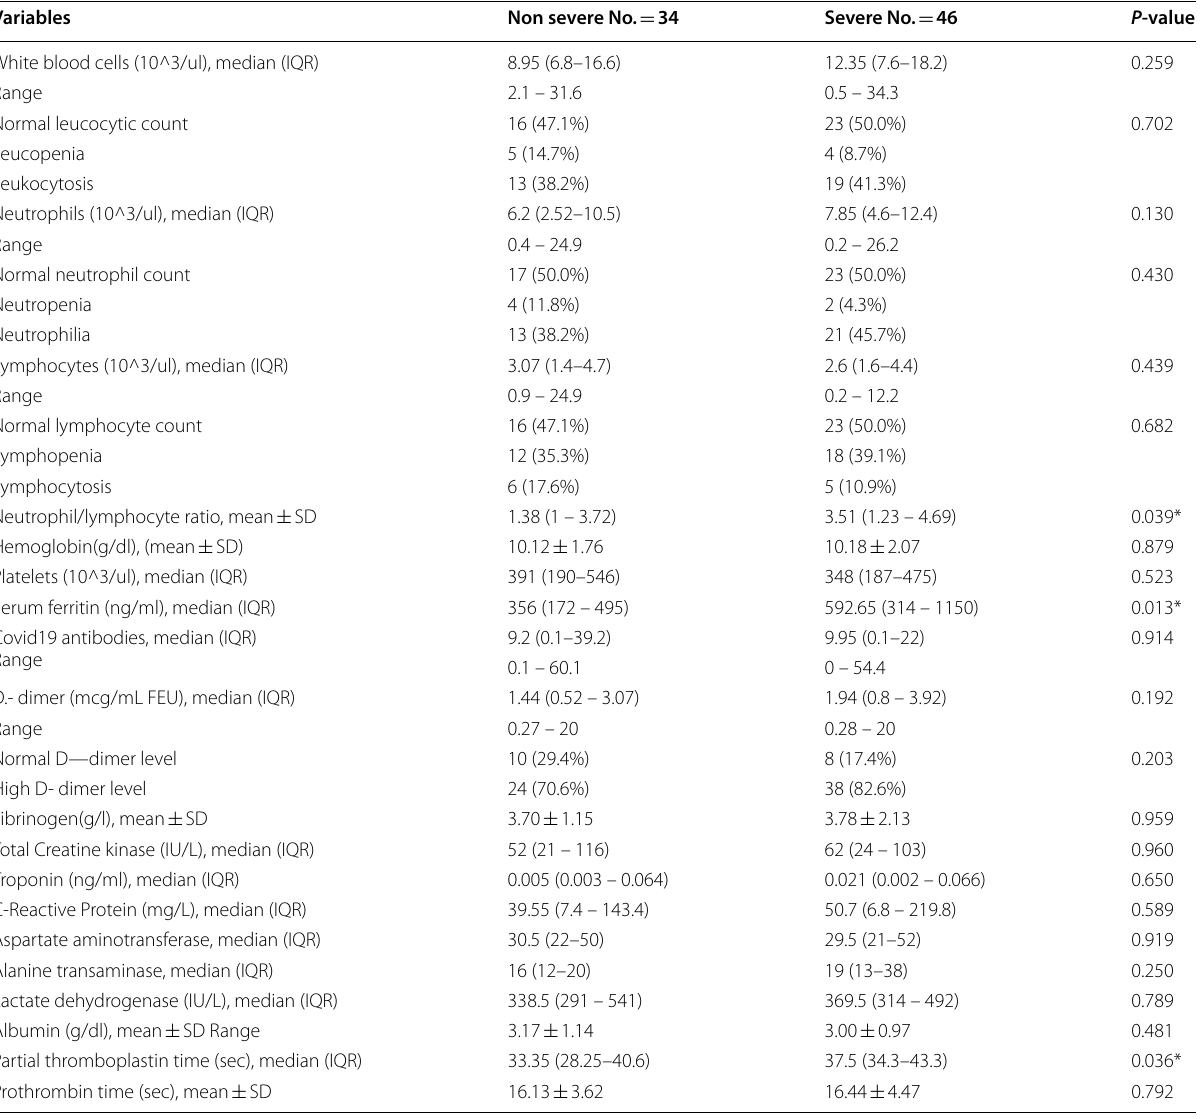
Table 4 Laboratory investigations among the studied patient